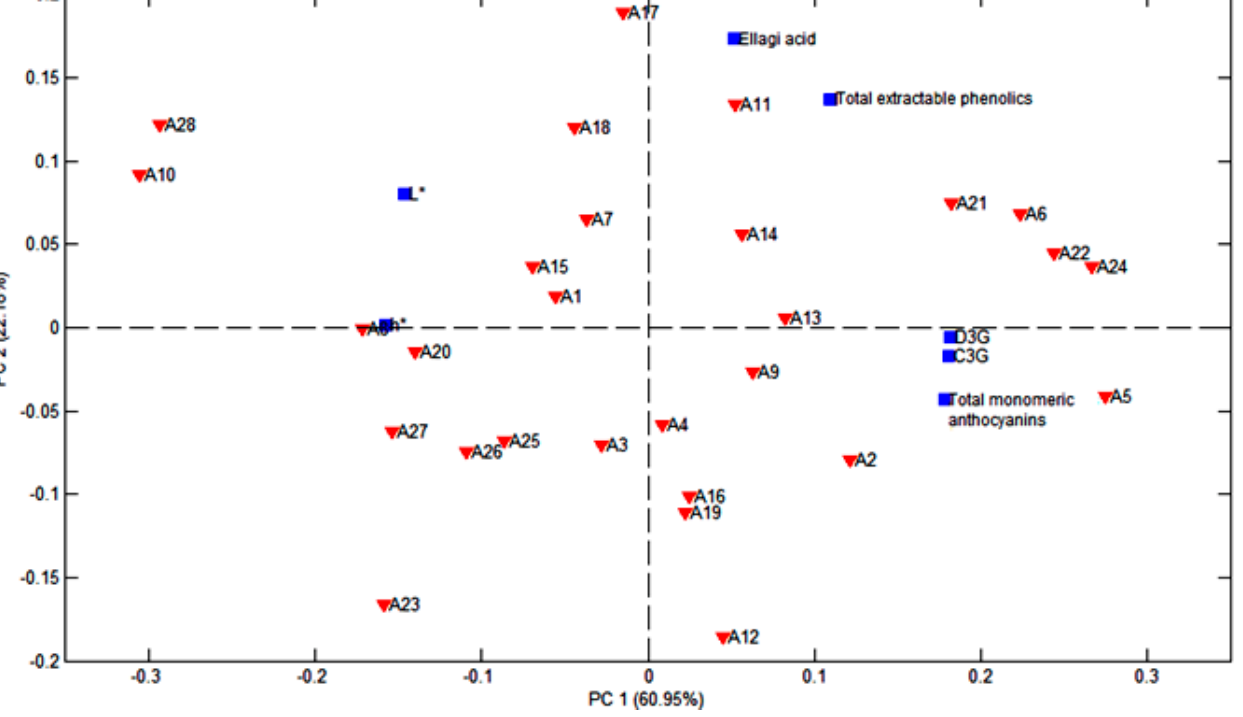
Figure 6. Biplot graphic PC1 vs. PC2 of polyphenol data and color parameters.